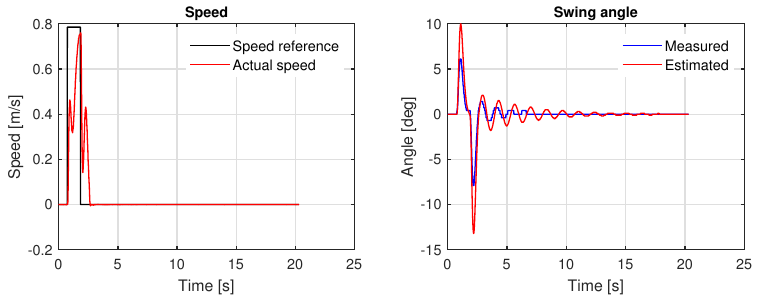
Figure 11. Speed reference and the actual speed and the measured and estimated swing angles when the swing angle feedback control using the measured angle is applied.